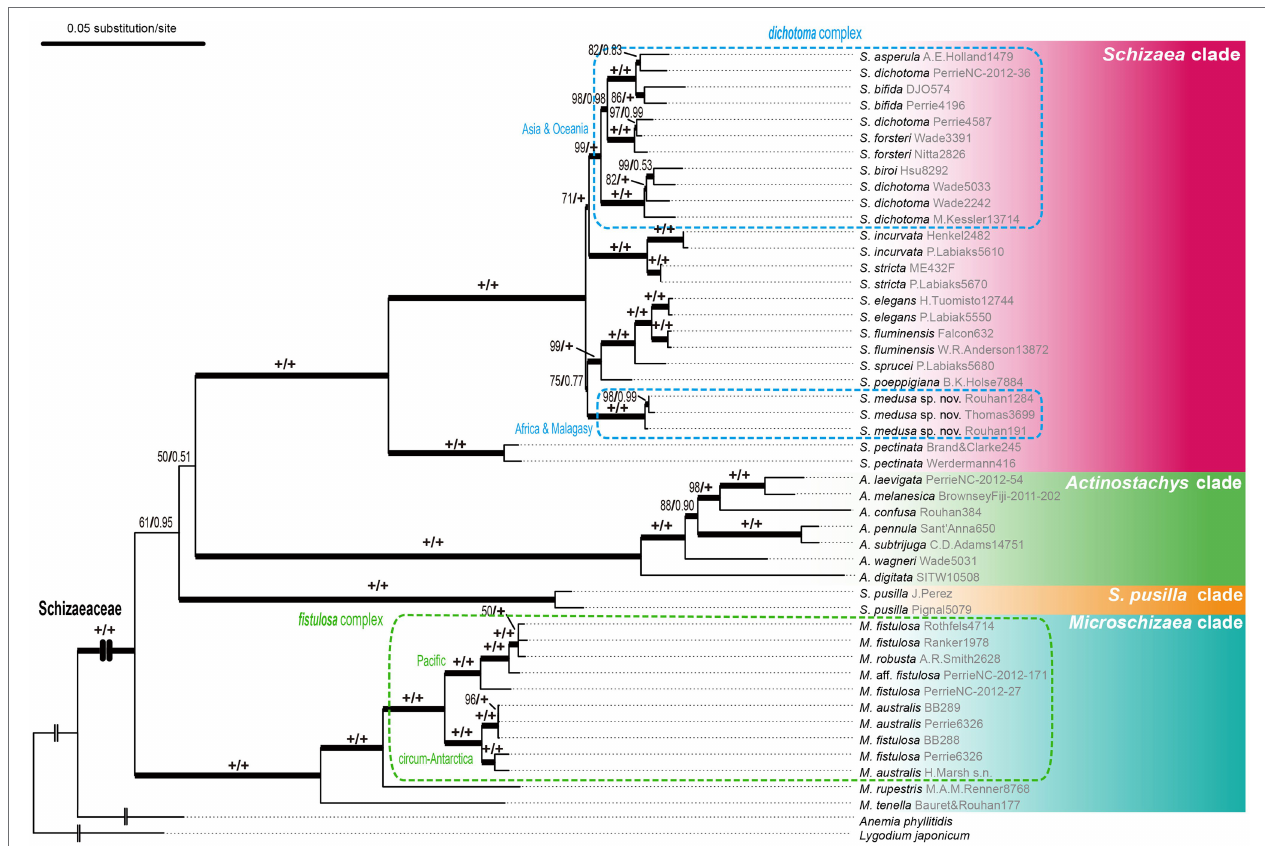
FIGURE 3 | The plastid phylogeny of Schizaeaceae based on the rpoC2 + rbcL + trnL-L-F dataset. Maximum likelihood ultrafast bootstrap supports (UFBS) and Bayesian inference (BI) are indicated on each branch as